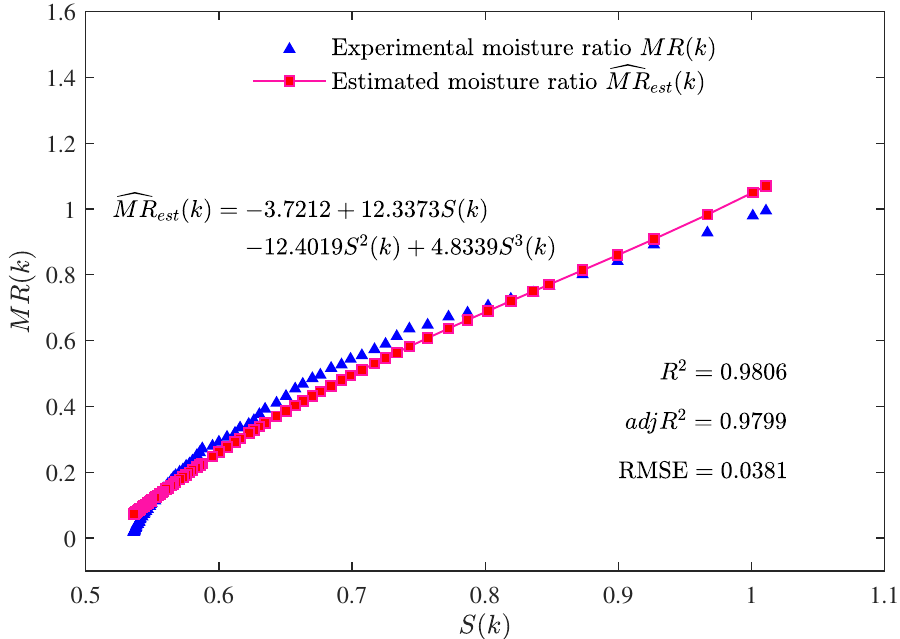
Figure 7. The estimated moisture ratio (cid:100) MR est ( k ) versus the shrinkage S ( k ) for n =